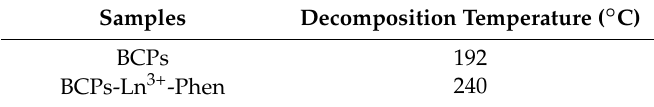
Table 3. Decomposition temperature of BCPs and BCPs-Ln 3+